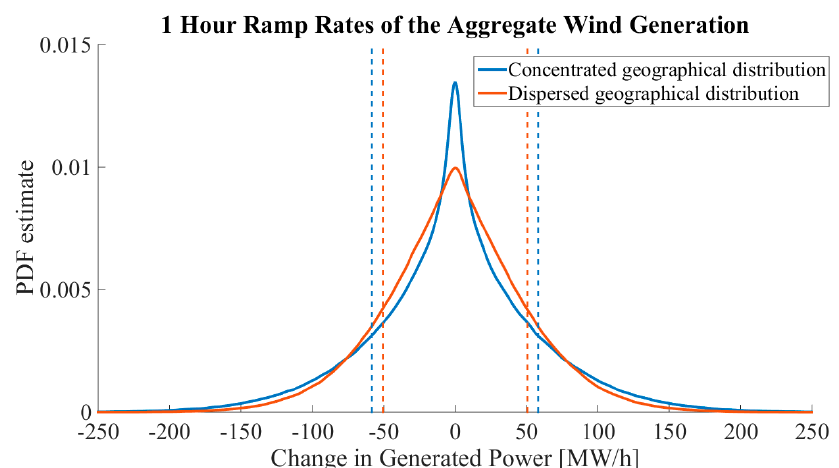
Figure 11. The one-hour ramp rate PDFs estimated from the aggregated wind power generation with dispersed and concentrated geographical distribution. The dotted lines with the same colors illustrate the standard deviations of the one-hour ramp rates. The presented simulation results are averages of the 100 MC runs.